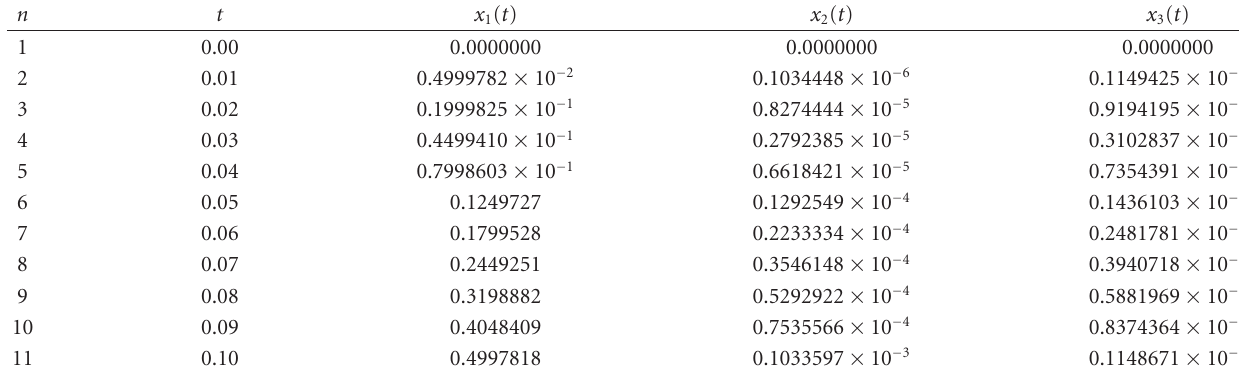
Table 3: Result for step